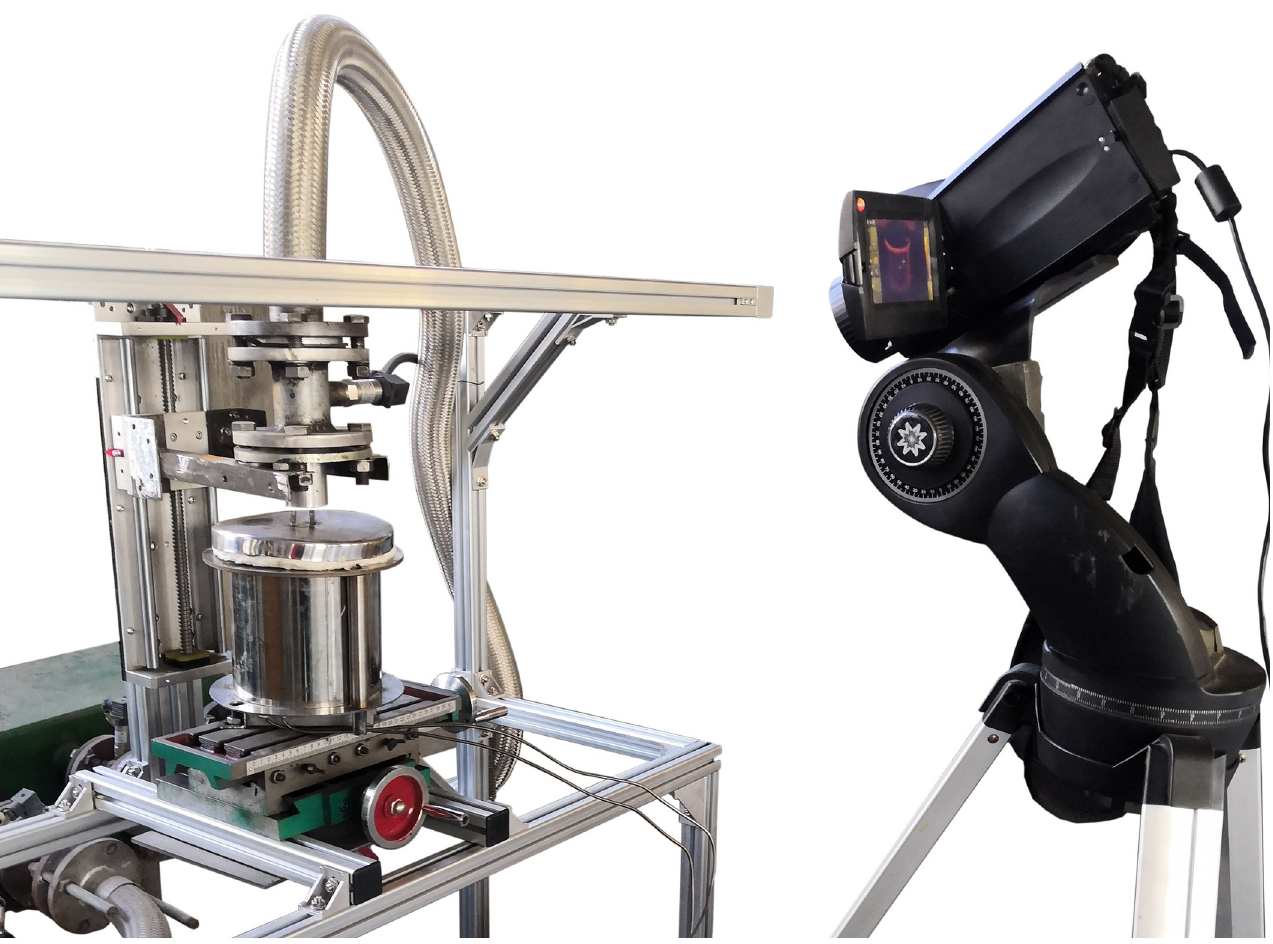
Fig 6. Partial digital photograph of the experimental